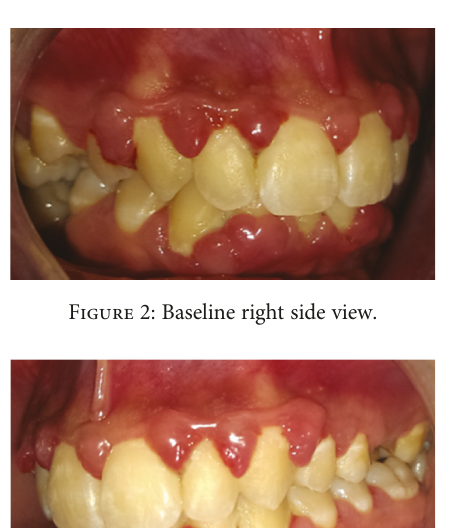
Figure 1: Baseline front view.